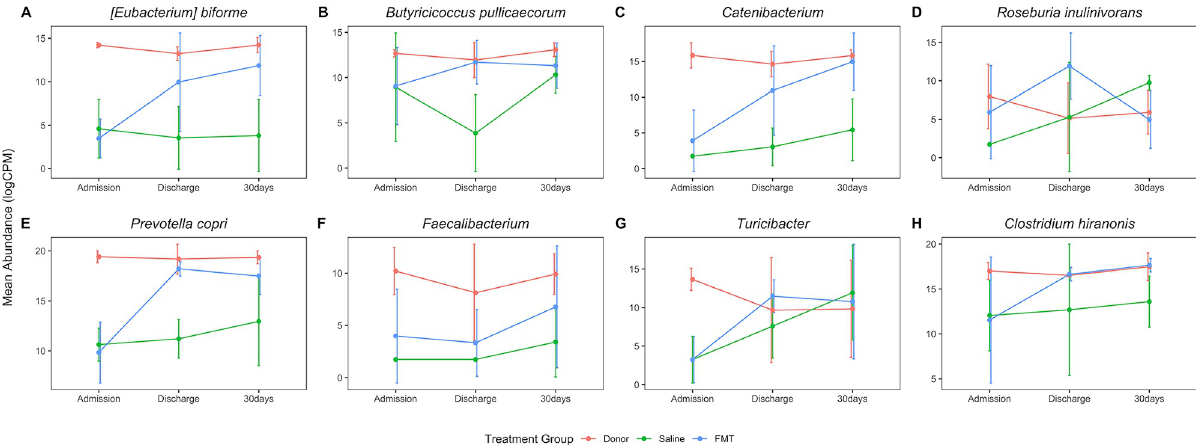
Fig 7. Changes over time in specific taxa following FMT. The abundance of each OTU was log-transformed and normalized to counts per million (y- axis) and plotted against the sample collection time (x-axis). Dots and error bars are the mean ± SD. (A-H) The abundance of metabolically important taxa, including short-chain fatty acid and secondary bile acid generating bacteria, increased following FMT. CPM: counts per million; FMT: fecal microbial